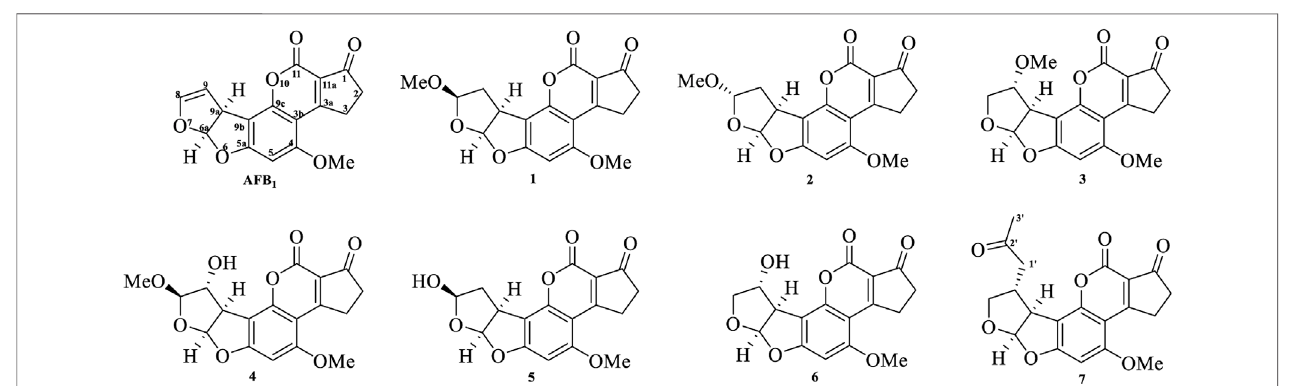
FIGURE 4 | Structures of AFB 1 and